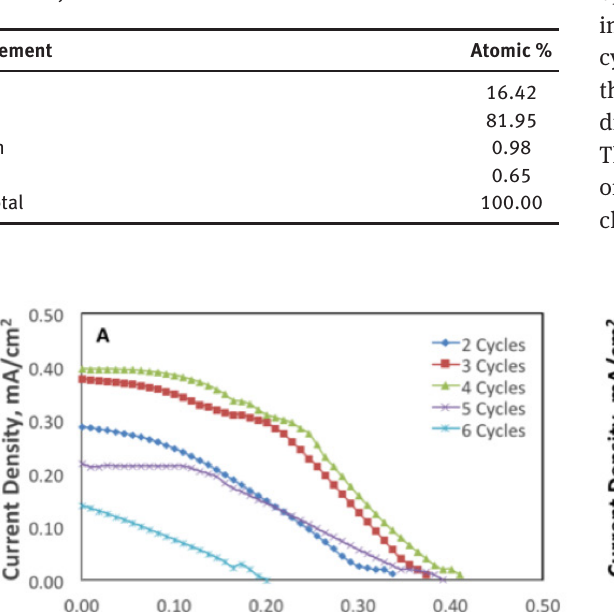
/SnS as detected via 2